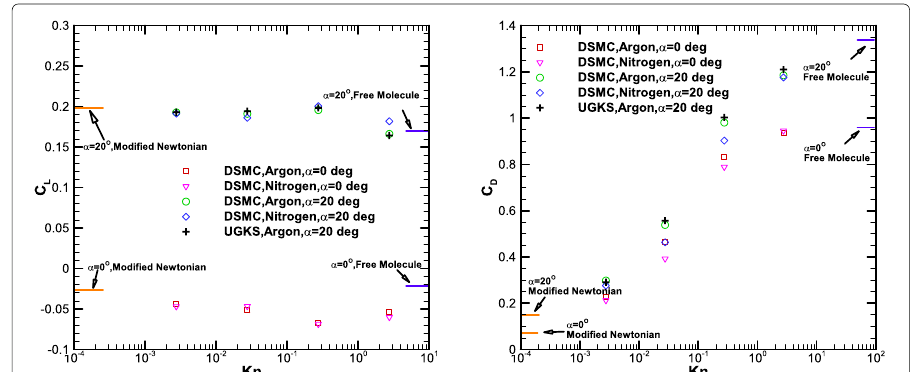
Fig. 9 Comparison of lift and drag coefficients vs the Knudsen number between DSMC and